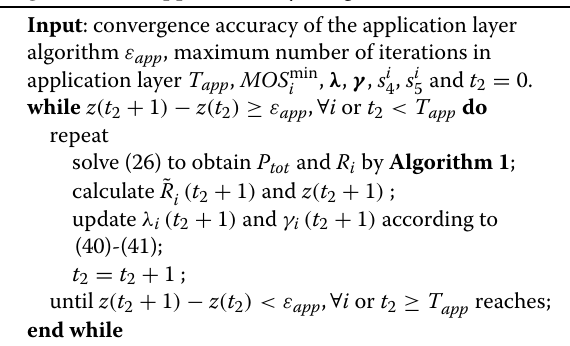
Algorithm 2: Application layer